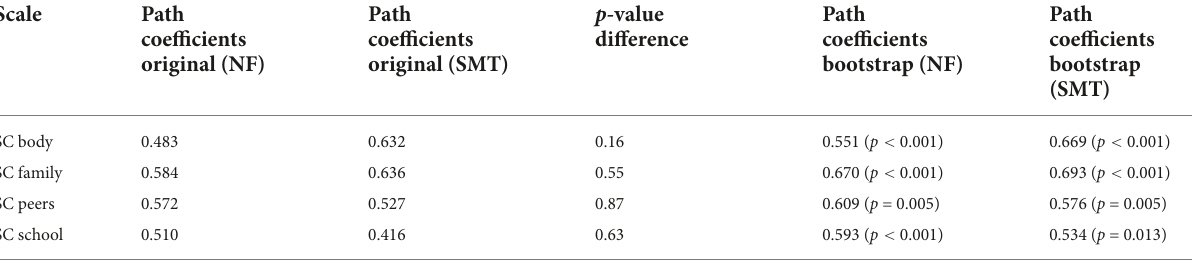
TABLE 6 Original path coefficients of self-concept interview subscales in NF ( n = 55) and SMT ( n = 58) after imputing missing values with k-nearest neighbor (kNN)